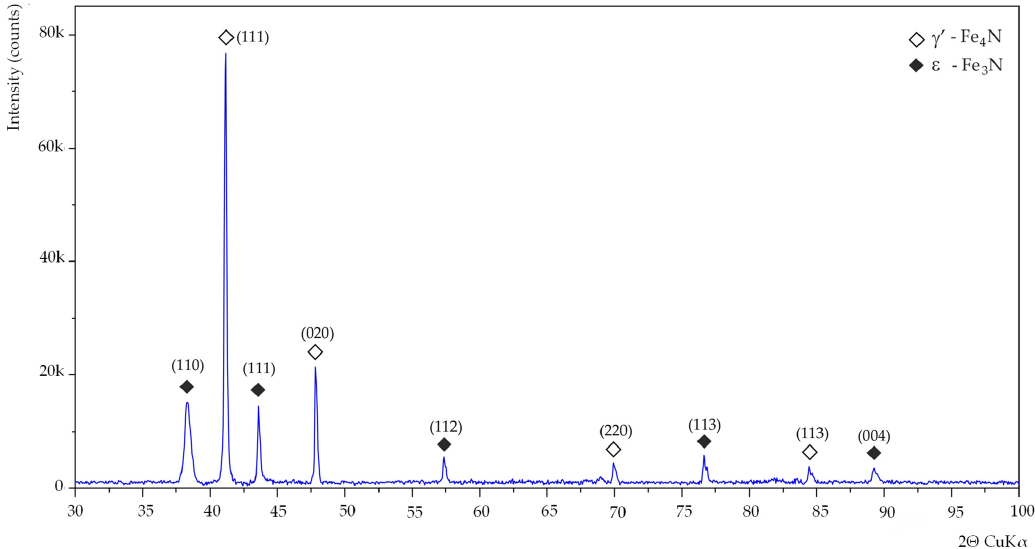
Figure 4 . Diffraction pattern acquired from samples H 23#1 , C 27#1 , C 23#1 , C 27LS#1 , C 30#1 , H 23LS#1 , C 30LS#1 and C 27#2 after removing the oxide layer.